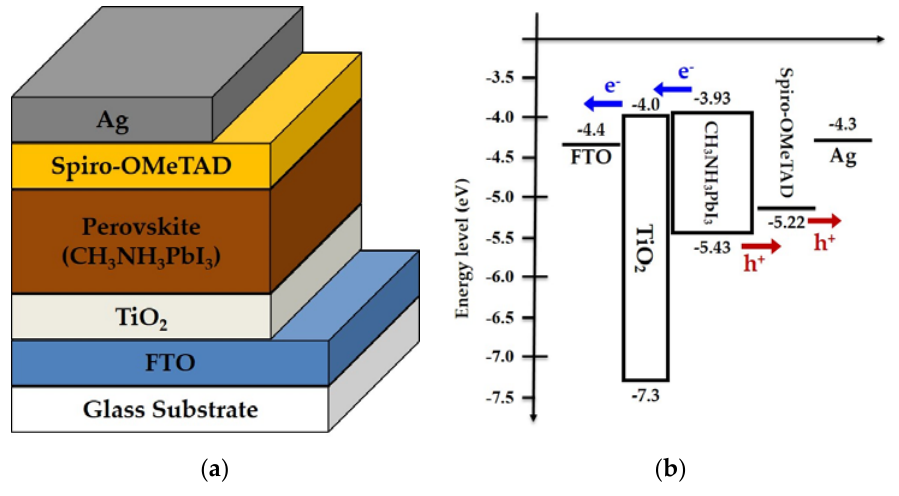
Figure 1. ( a ) Schematic structure of device and ( b ) energy level diagram of device in this study.